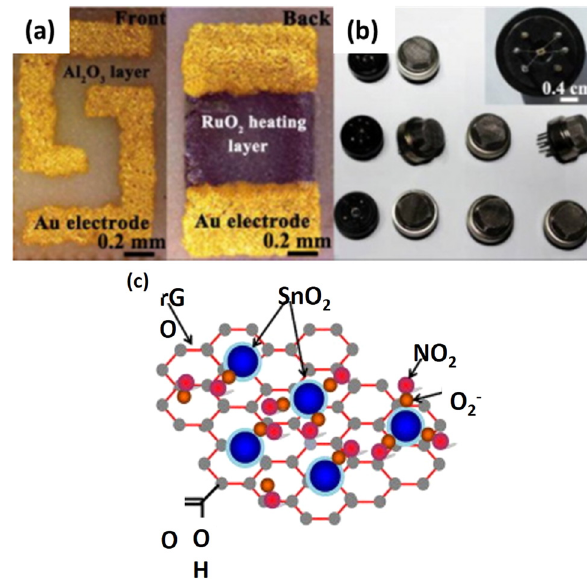
Figure 25: ( a ) Images of blank sensor used to detect NO 2 analytes, ( b ) images of the coated sensor with rGO/SnO 2 nanocomposites as sensing materials, and ( c ) as sensing mechanism on the adsorption behaviour of NO 2 molecules on the rGO/SnO 2 nanocomposite. Reproduced from ref. [ 160 ]